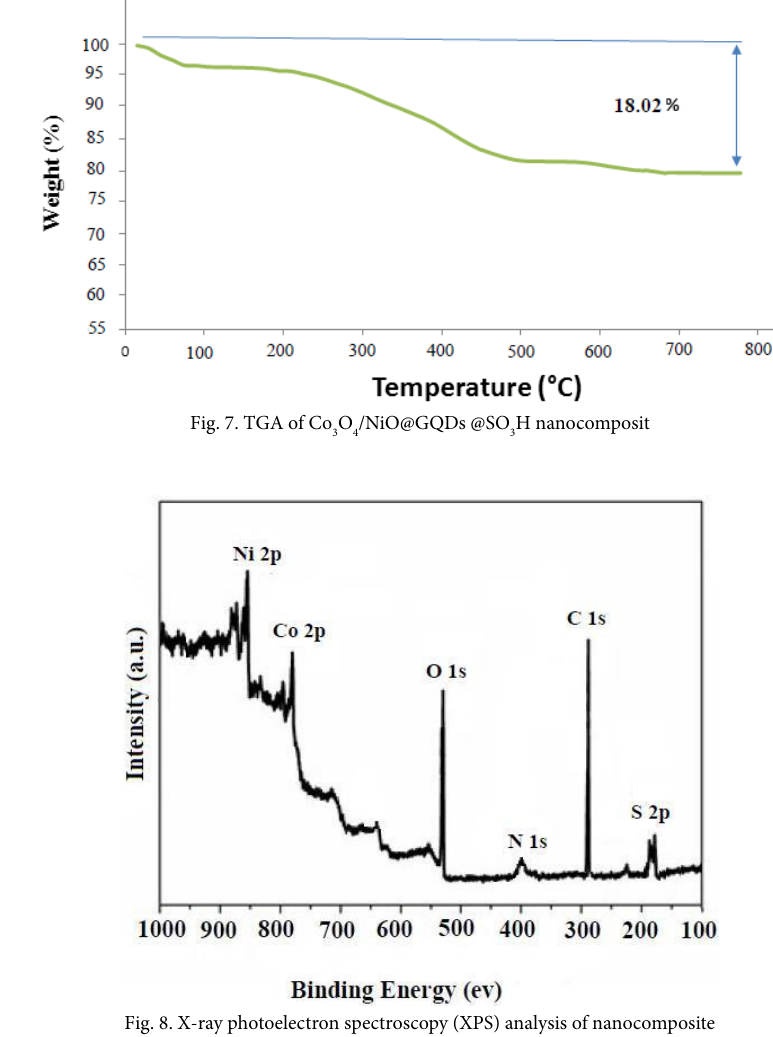
Fig. 8. X-ray photoelectron spectroscopy (XPS) analysis of nanocomposite